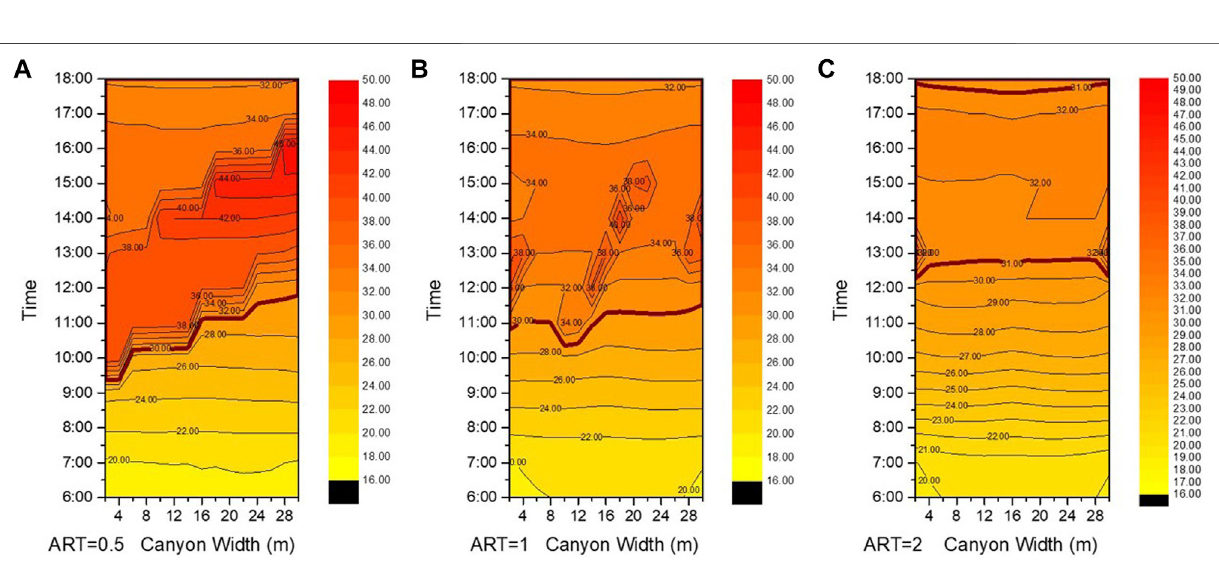
Frontiers in Environmental Science |